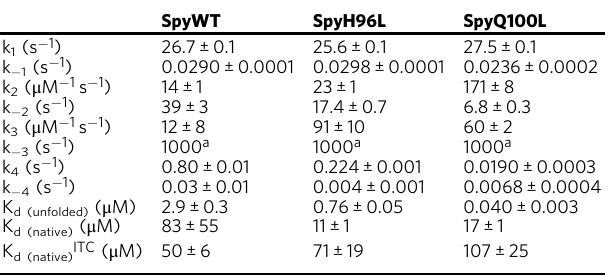
Data were collected under conditions containing 0.83M urea. The complete fi tting results for each data set can be found in Supplementary Fig. 8. a k -3 was fi xed at 1000s − 1 . K d(unfolded) = k − 2 / k 2 ; K d(native) = k − 3 / k 3 ; K d(native) ITC was determined by